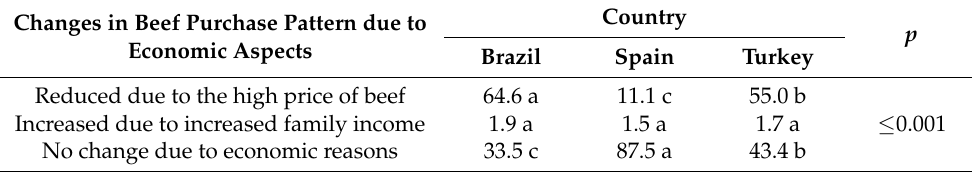
Table 3. Changes in beef purchase pattern due to economic